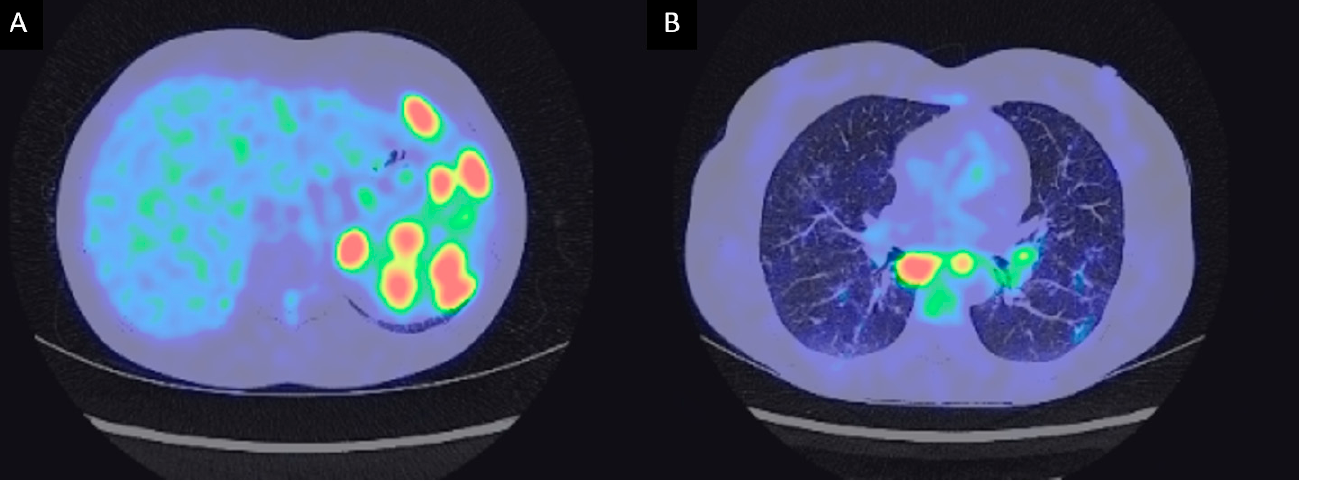
Figure 2. Axial PET-CT acquisitions showing increased metabolic activity in the spleen nodules ( A ) and in mediastinal lymph nodes ( B ).